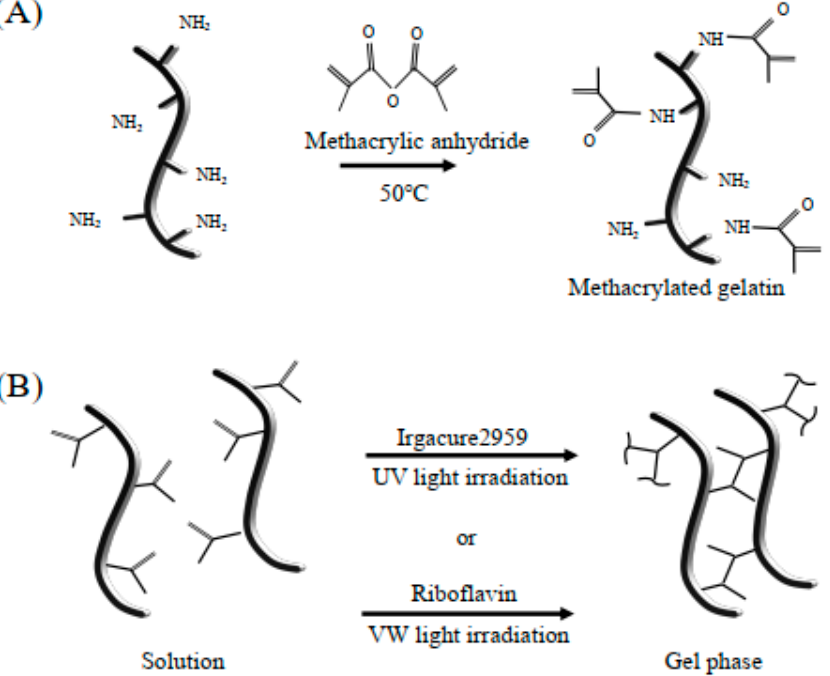
Figure 7. Synthesis of methacrylated-gelatin hydrogel. ( A ) Gelatin macromers containing primary amine groups were reacted with methacrylic anhydride to add methacrylate pendant groups. ( B ) To create a hydrogel network, the methacrylated gelatin was crosslinked using UV light irradiation in the presence of a photoinitiator, i.e., Irgacure 2959, or VW light irradiation in the presence of the photoinitiators riboflavin and triethanolamine. The solution was free flowing before UV or VW light treatment, and gelation occurred after crosslinking.